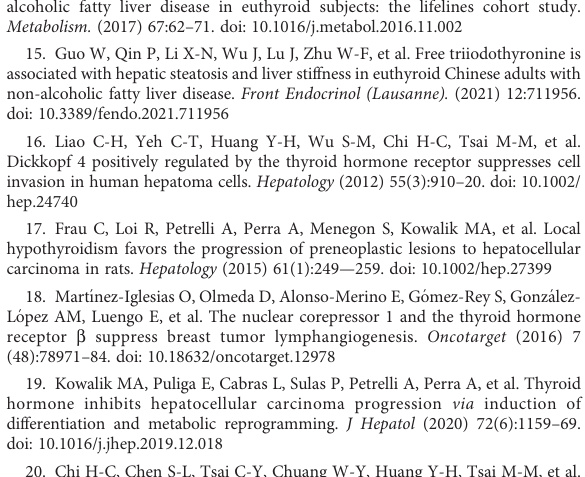
SUPPLEMENTARY FIGURE 2 (A) PCA of miRNAs in preneoplastic nodules and control samples ; (B) PCA of genes in preneoplastic lesions (nodules), and preneoplastic nodules control samples; (C) Canonical pathway analysis in preneoplastic lesions (nodules), and control samples.